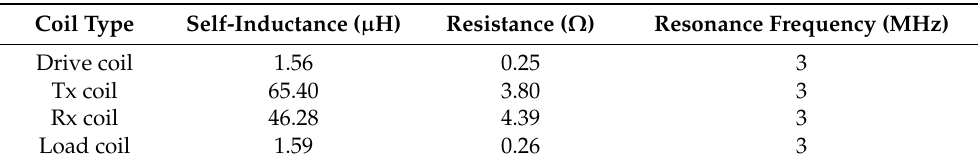
Table 1. Electrical parameters of coupling coils.